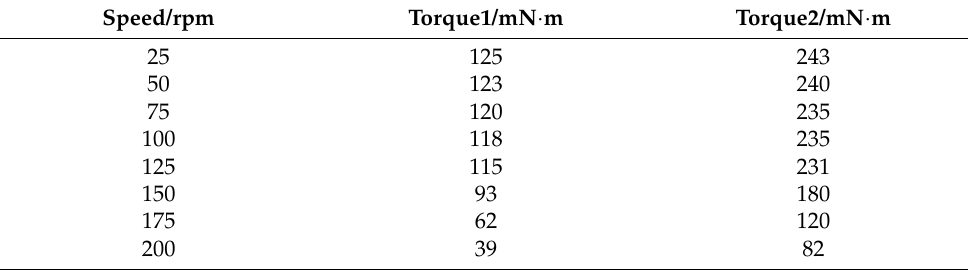
Table 3. Output torque at different